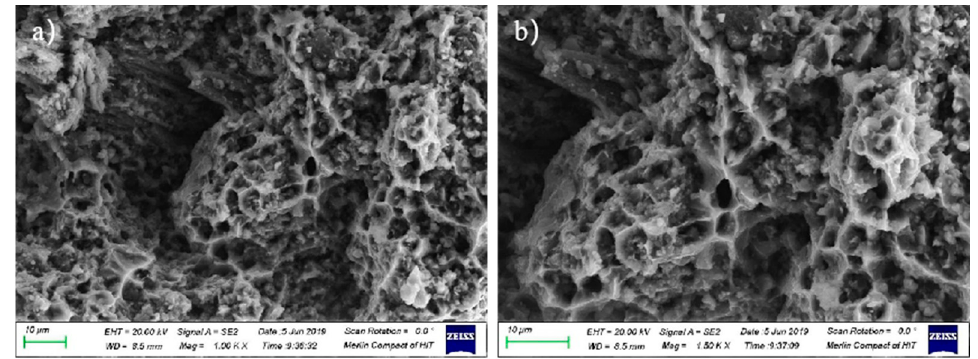
Figure 8. The high-temperature tensile fracture at 450 °C of the extrusion: ( a ) 1000 times; ( b ) 1500 times.